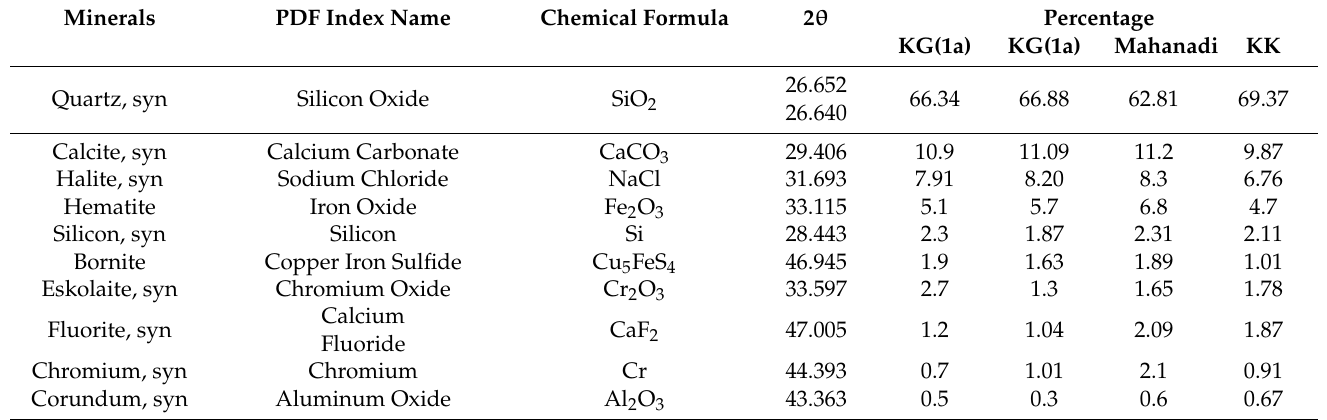
Table 5. Approximate percentage of minerals observed in the XRD Diffractogram.